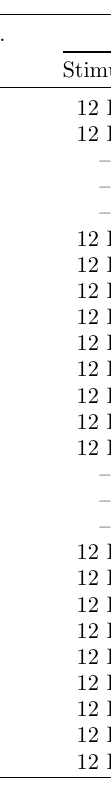
Table 1. List of applied